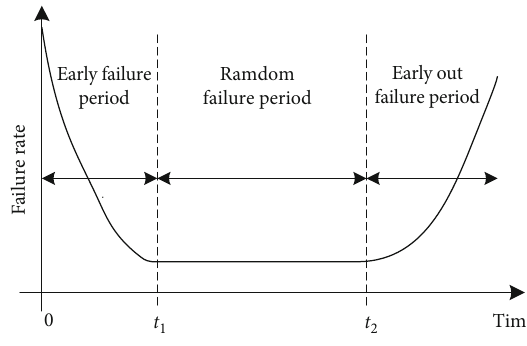
Figure 1: Typical risk ratio curve